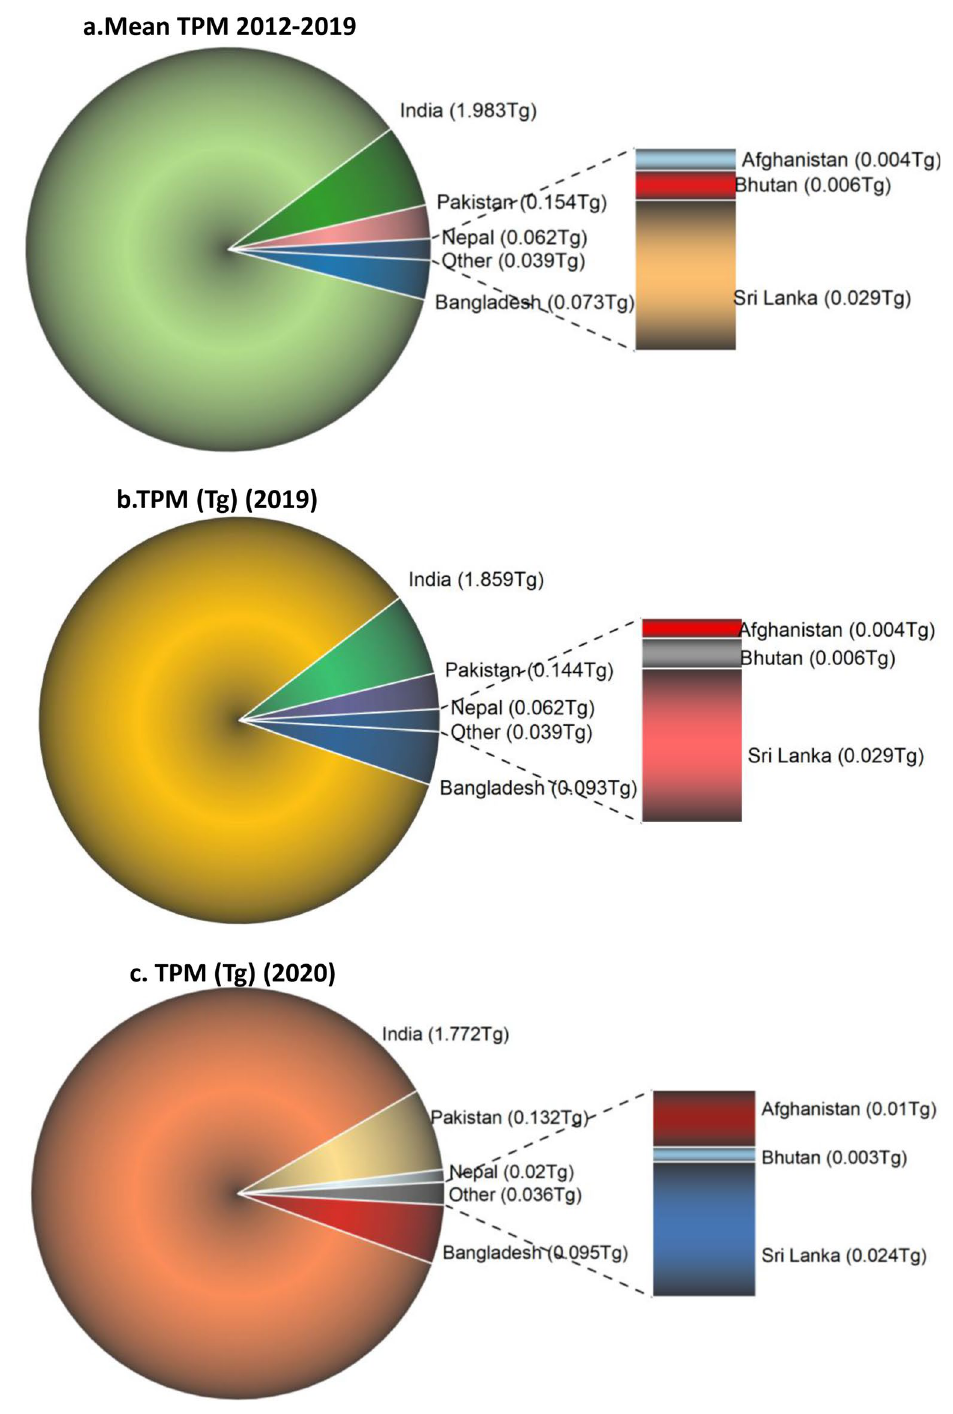
Figure 12. ( a )–( c ) Total Particulate Matter (TPM) emissions (Tg) from South Asian countries. ( a ). Mean TPM (Tg) during 2012–2019; ( b ). 2019-non COVID year; ( c ). 2020-COVID year. A reduction in TPM emissions has been observed during COVID-2020 for most of the countries, except Afghanistan and Bangladesh. 2020- COVID year had an overall reduction of ~ 0.26 Tg TPM emissions compared to previous non-COVID years and 0.14 Tg less than 2019 non-COVID